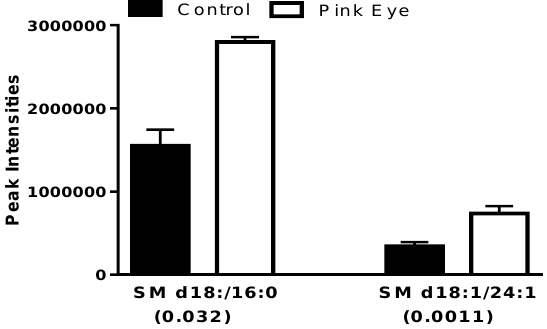
Figure 4. Sphingomyelins in bovine tear fluid. Data are presented as peak intensities for the ions of each of the lipids ± SEM. SM, sphingomyelin. p values are in brackets.